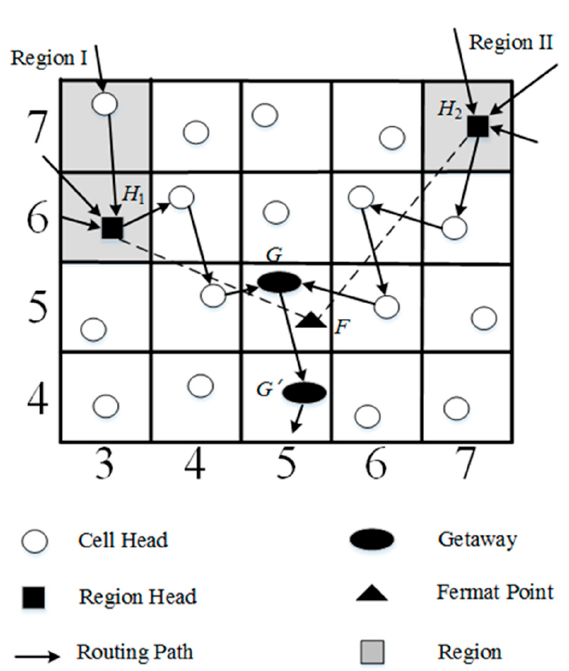
Figure 5. Gateway adjustment.